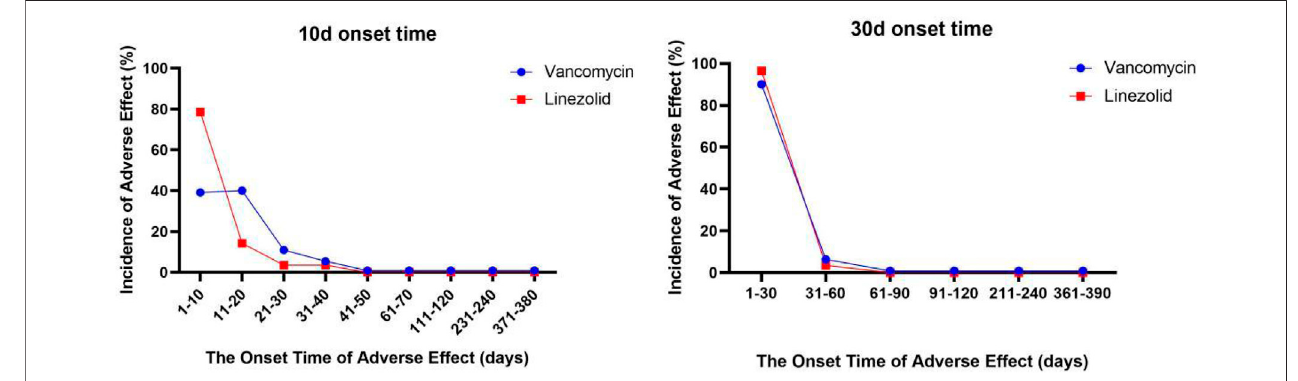
FIGURE 1 | The onset time of vancomycin- and linezolid-associated